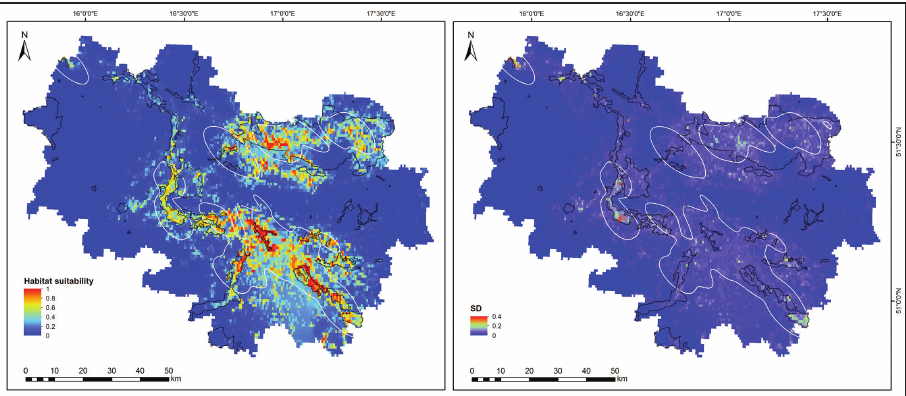
Figure 3. Averaged habitat suitability map for Cerambyx cerdo L., 1758 in south-western Poland (right) and standard deviations of predicted probabilities of occurrence (left) from MaxEnt models. Black-bor- dered areas show the network of existing protected areas (OPAs), white-bordered show the 95% kernel density isopleth.